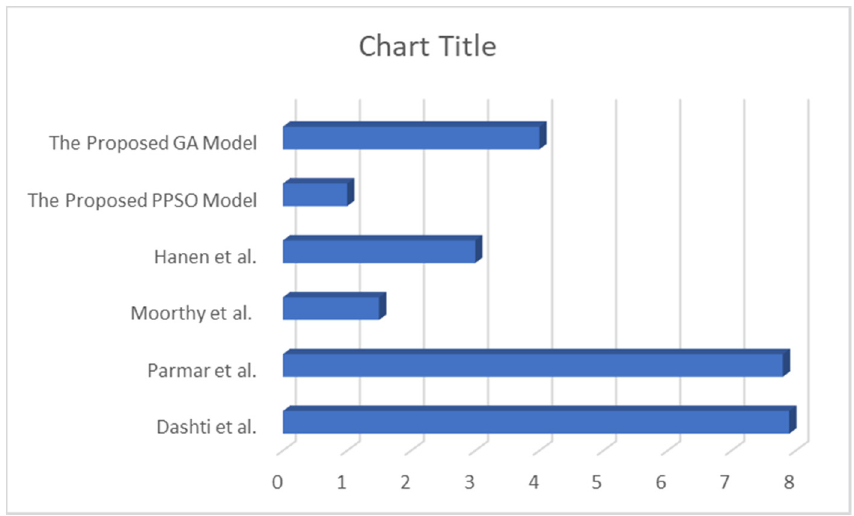
Figure A1. The execution time of the proposed model compared to state-of-the-art methods.